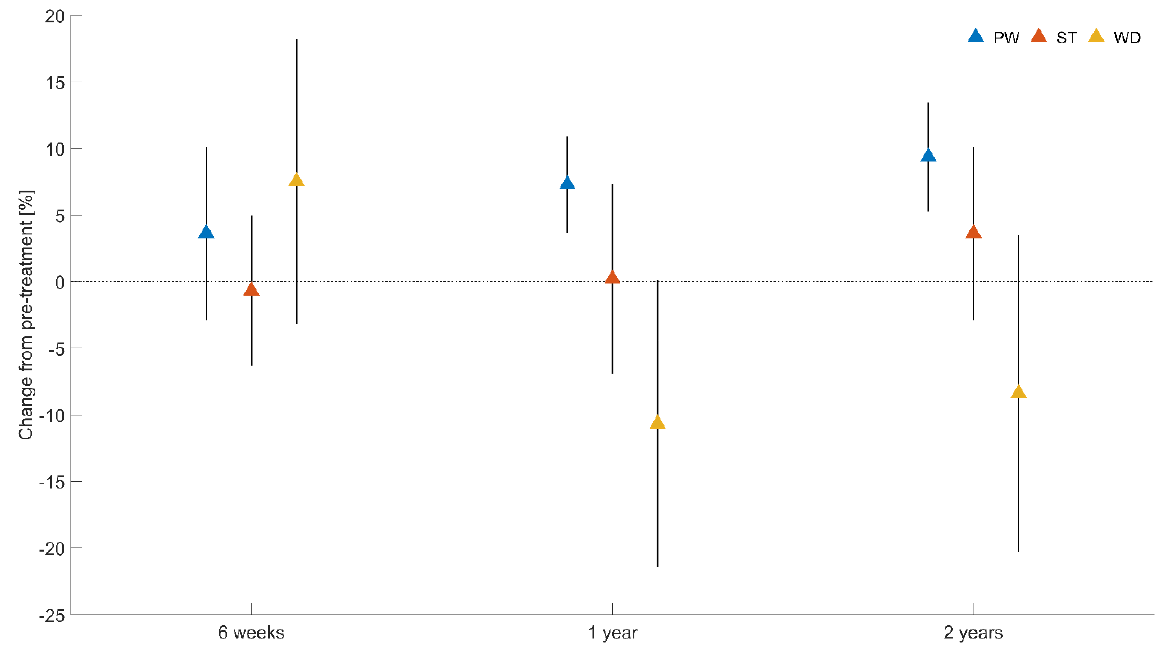
Figure 3. Time changes of percentage weight (PW), standing steadiness (ST) and standing asymmetry (WD), according to baseline measurements. Values are mean with 95% confidence intervals.